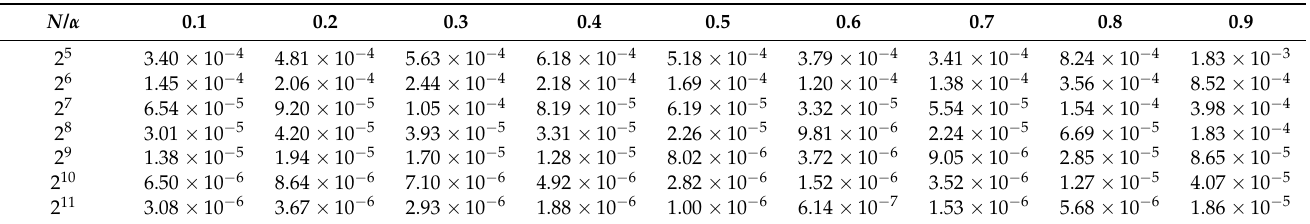
Table 5. The numerical error for American put options using the RBF-FD-IL1-OS method with M = 40.